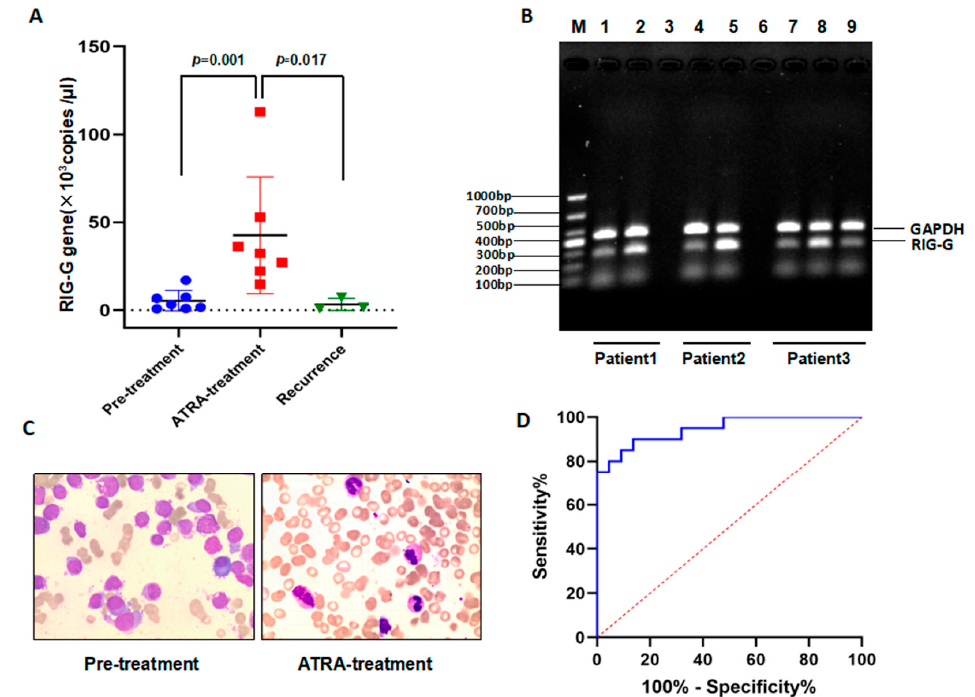
Figure 4. The prognosis monitoring application and diagnostic value of RIG-G gene in APL patients. ( A )After ATRA- treatment, the expression of RIG-G gene in peripheral blood of APL patients was significantly increased ( n = 7, p = 0.001), But it was lower again in 3 recurrence patients ( p = 0.017). ( B ) Detection PCR amplification of RIG-G gene products by 2% agarose gel electrophoresis of 3 APL patients (lane 1,4,7 = Pre-treatment; lane 2,5,8 = ATRA-treatment; lane 9 = Recurrence). ( C ) Changes of promyelocytic cells in bone marrow of patients with APL. ( D )ROC curve to the diagnostic efficacy of RIG-G gene in APL